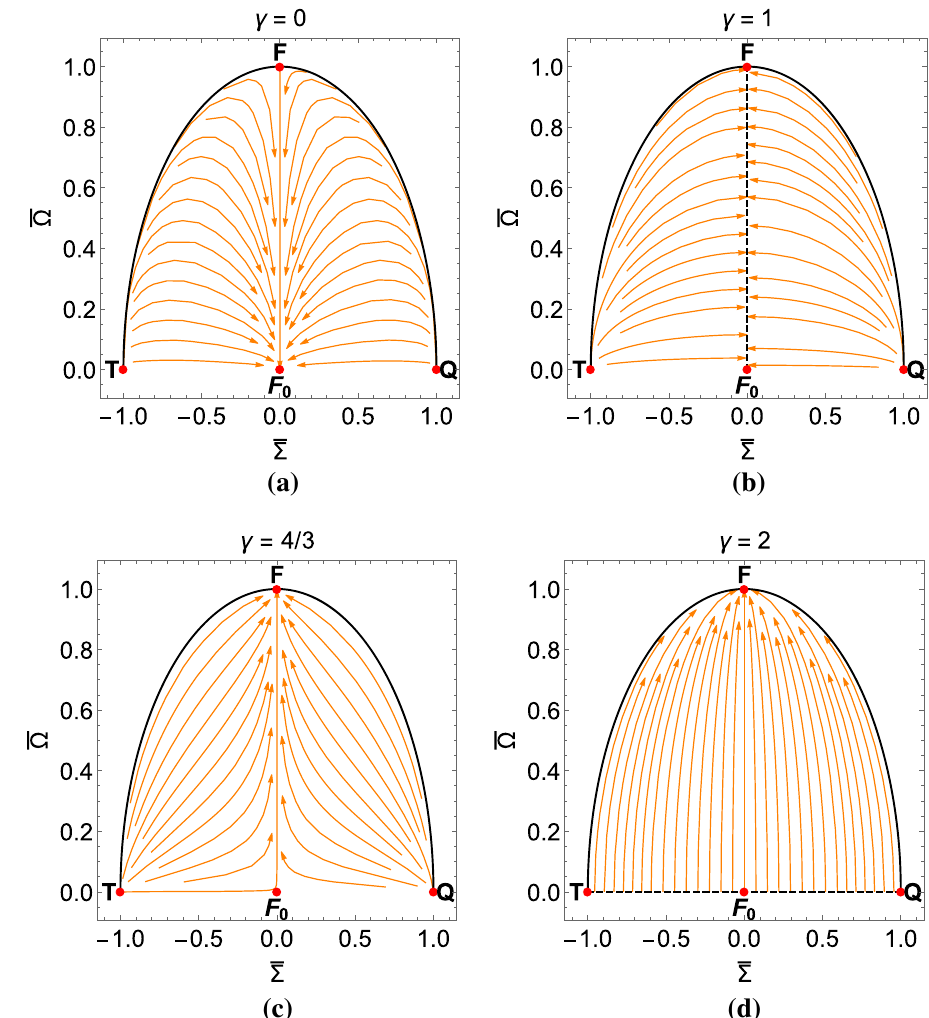
Fig. 1 Phase plane for system (72a), (72b) for different choices of γ. For γ = 1 the dashed vertical line : ( ¯ Ω, ¯ Σ) = ( ¯ Ω ∗ , 0 ) is L 2 stable. For γ = 2 the dashed